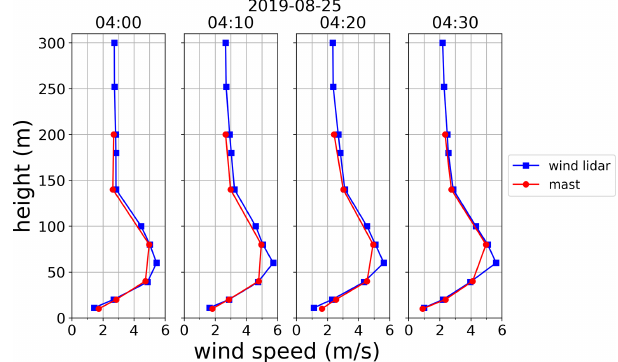
Figure 3. Example of a low-level jet in the early morning of 25 Au- gust 2019, highlighting the benefit of more measuring levels pro- vided by the wind lidar compared to the mast. The times (UTC) indicated at the top of the panels are the start of the 10min